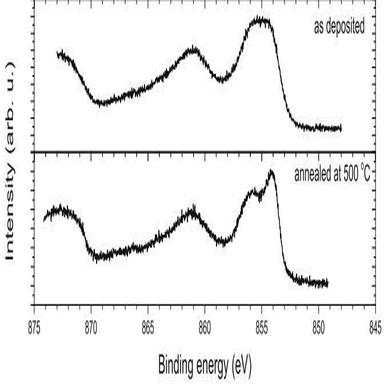
XPS spectra due to Ni 2p3/2 for a 1700-nm-thick NiO film (Sample 1) in as-deposited state and after annealing at the shown temperature. Intensity (arbitrary units) is shown on the ordinate axis.